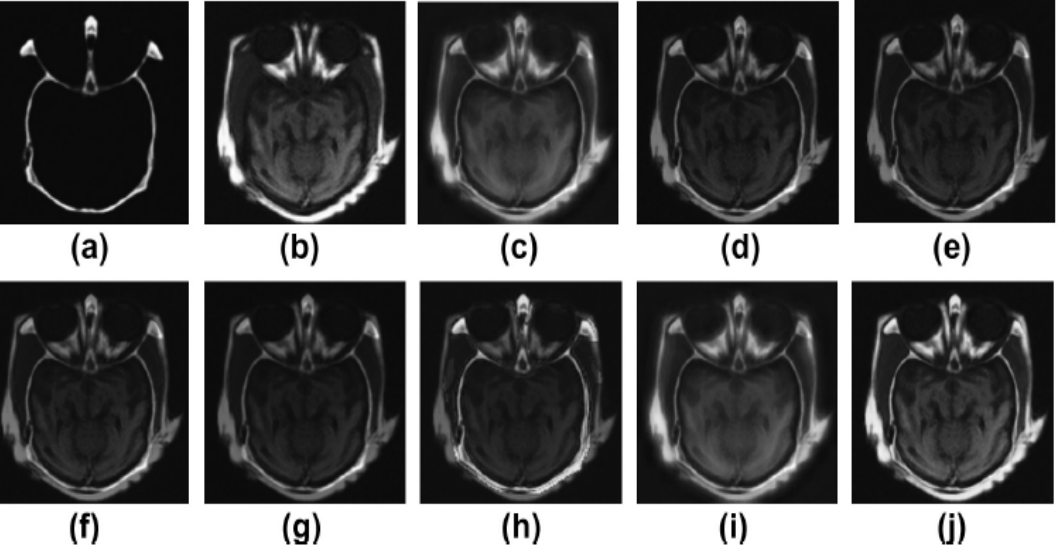
Figure 2. Results of multimodality medical image fusion; ( a ) input multimodality medical image 1;